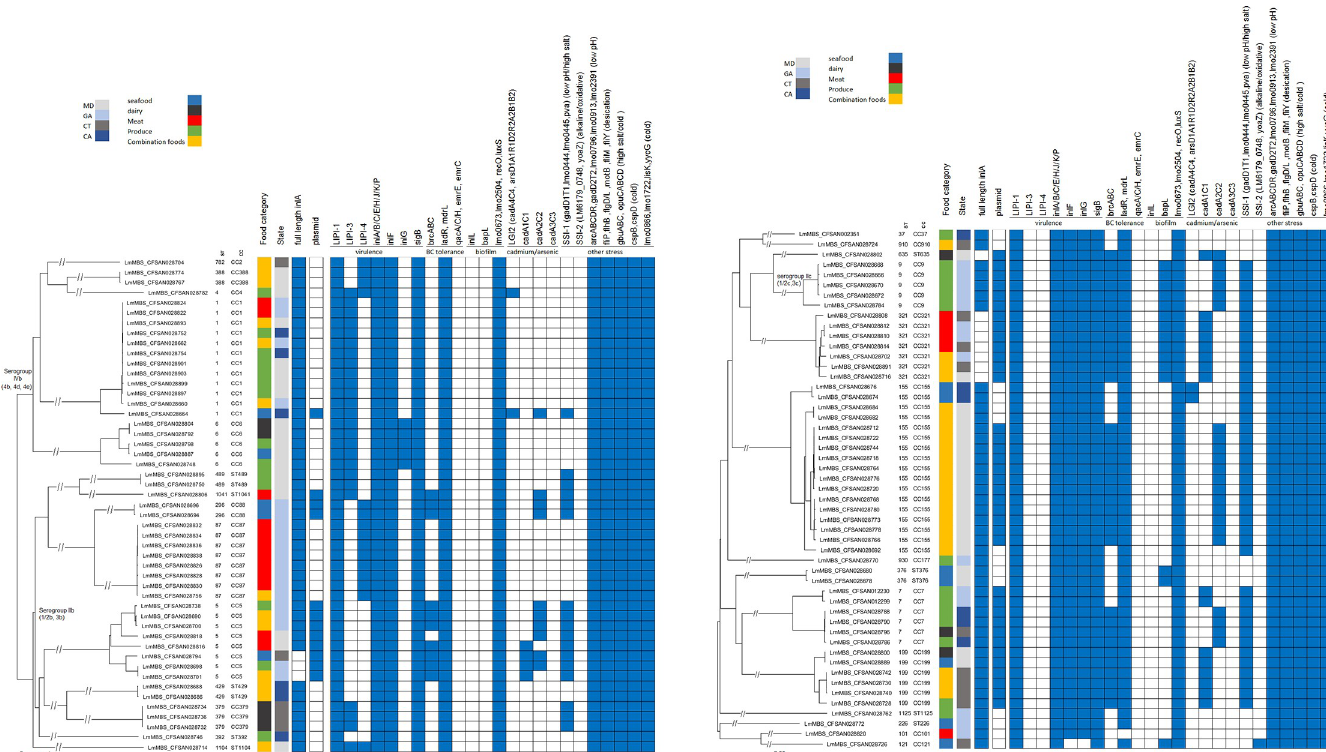
Fig 1. Phylogenetic trees of (A) lineage I (n = 49), and (B) lineage II (n = 51) L . monocytogenes isolates from five food groups included in the 2010–2013 Lm MBS, constructed by the neighbor-joining algorithm using pairwise allelic differences generated by core genome multilocus sequence typing (cgMLST). Shown is the relatedness of the isolates and, for each isolate, the designation of serogroups, clonal complex (CC), sequence type (ST), the presence (filled space) and absence (open space) of full length inlA, plasmid, and selected genes associated with virulence and stress resistance. The food categories are color coded.